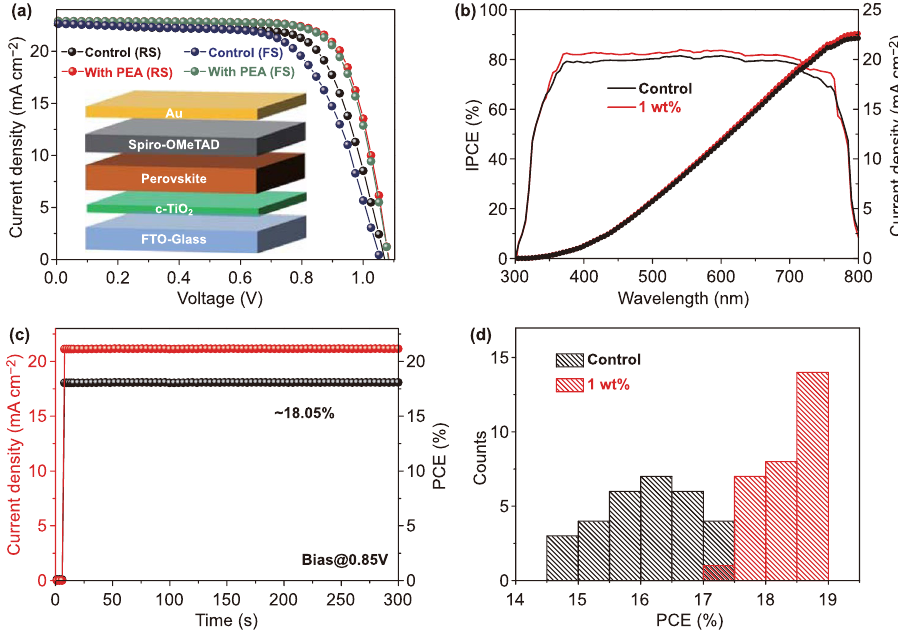
Fig. 4 a J–V curves of the MAPbI 3 devices with and without PEA (the inset gives the device structure). b IPCE spectra and integrated J SC of the two devices. c Steady-state current density and PCE at a constant bias of 0.85 V for the device with PEA. d Histogram of PCE